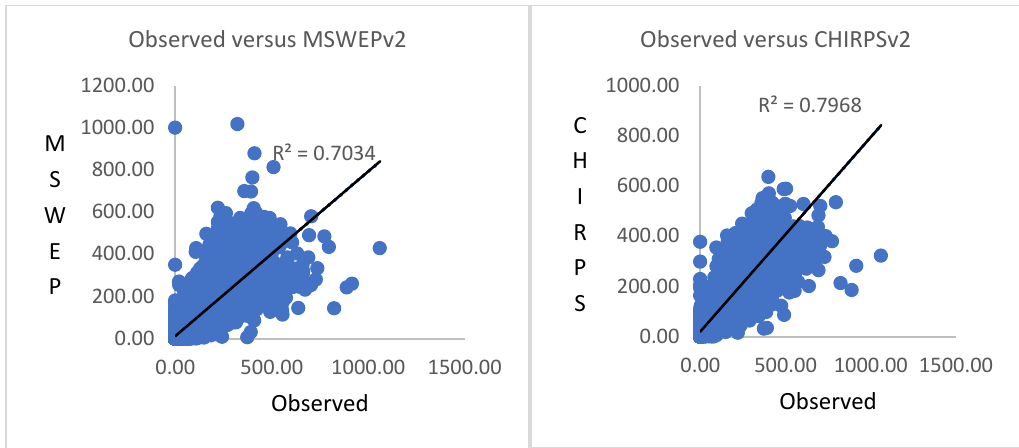
Figure 3. Scatterplots for monthly rainfall of Climate Hazards Group Infrared Precipitation with Stations version 2 (CHIRPSv2) and Multi-Source Weighted-Ensemble Precipitation version 2 (MSWEPv2) over the Upper Nile Basin (UBN).